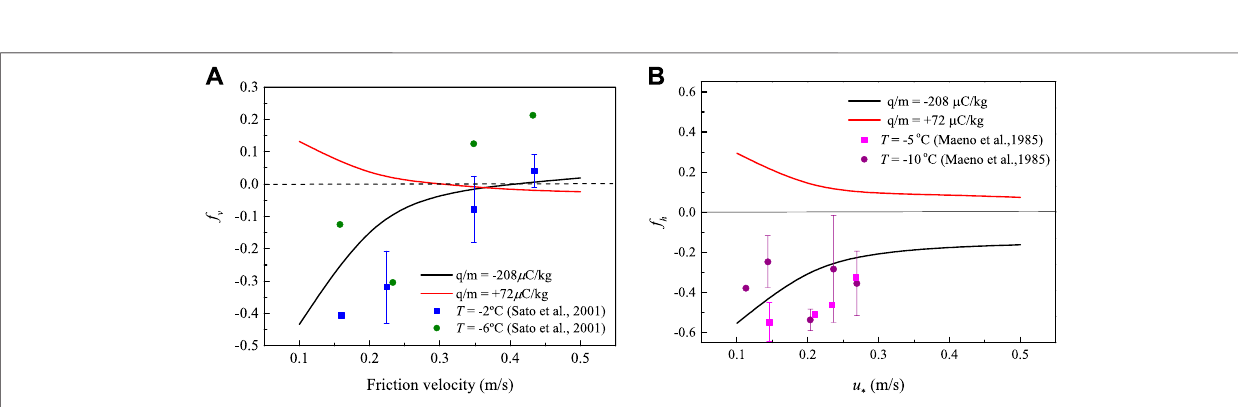
FIGURE 5 | (A) Dimensionless saltation height of positive and negative snow particles varies with the friction velocity. The red lines represents for the simulation resultsforpositively(redline)andnegative(blackline)charged particles. Greendots( T = − 6 ° C)andbluesquares ( T = − 2 ° C)areexperimental datafromSatoetal.(2001). (B) Dimensionless saltation length difference between charged particles to neutral particle. Purple dots ( T = − 10 ° C) and pink squares ( T = − 5 ° C) are experimental data from Maeno et al. (1985).